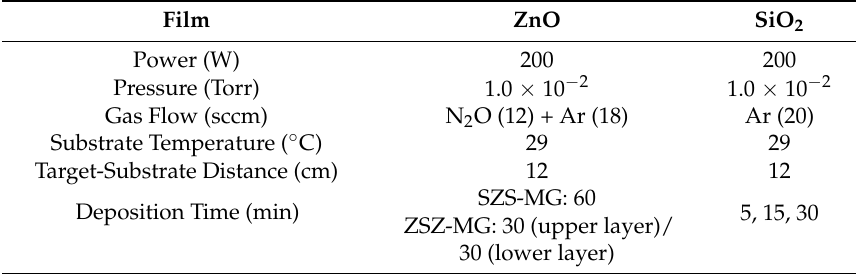
Table 1. Deposition conditions of ZnO and SiO 2 thin films for both SiO 2 /ZnO/SiO 2 micro-energy generators (SZS-MGs) and ZnO/SiO 2 /ZnO micro-energy generators (ZSZ-MGs) shown in Figures 5 and 6,